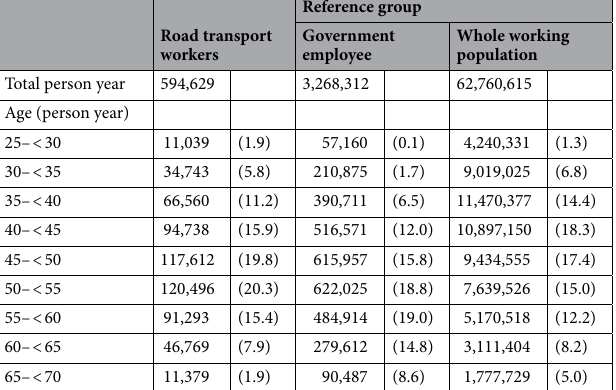
Table 1. Characteristics of the study participants in the first year of the study (2006).